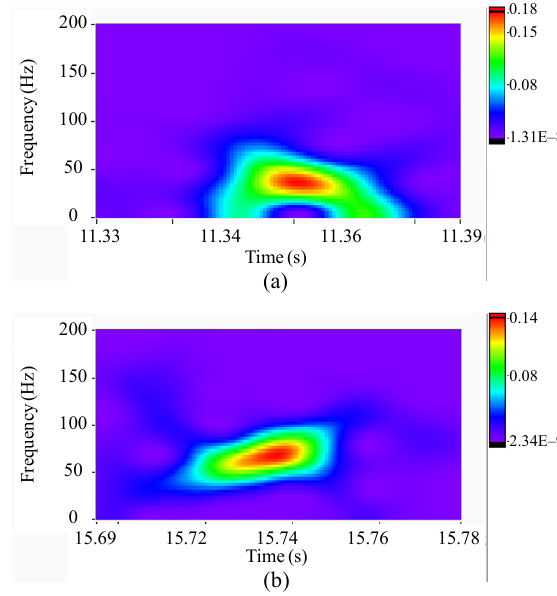
Fig. 26 STFT figure of (a) digging and (b) running or jumping at 1 m vertical distance away from the